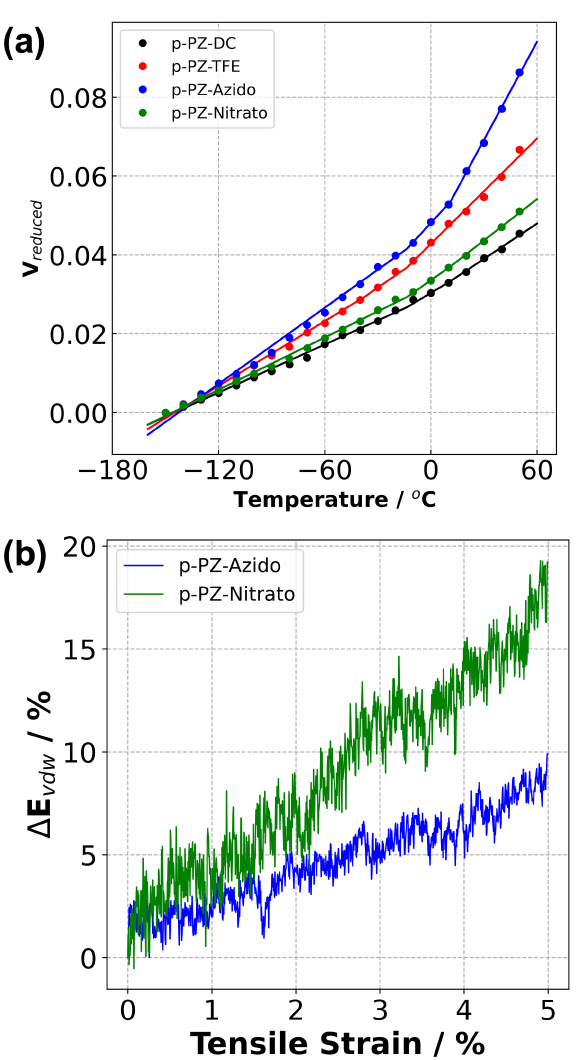
Figure 5. ( a ) Reduced volume versus temperature data for each polymerised system. ( b ) Change in vdW energy for the p-PZ-Azido and p-PZ-Nitrato systems in response to applied constant strain at 20 ◦